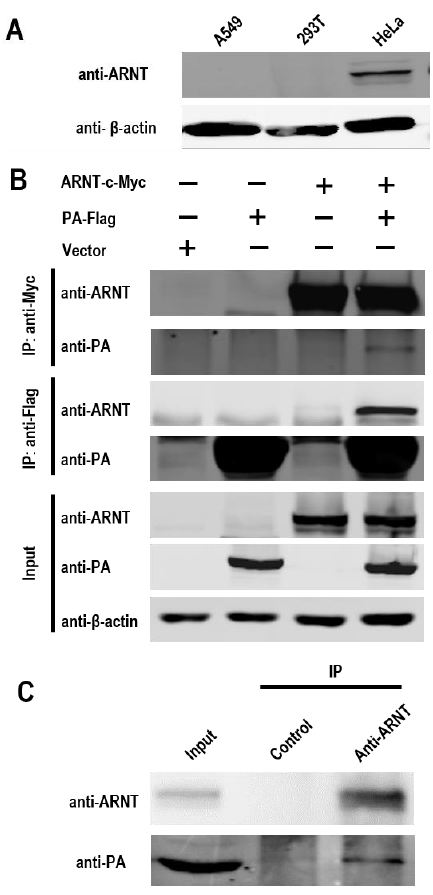
Figure 1. The interaction between ARNT and PA was analyzed by using co-immunoprecipitation assay. ( A ) The endogenous expression of ARNT in A549, 293T, and HeLa cells. ( B ) The interaction between PA and ARNT in 293T cells. 293T cells were co-transfected with the pCAGGS-PA-Flag and pCAGGS-ARNT-c-Myc plasmids. The cell extracts were subjected to co-immunoprecipitation assays by using either anti-Flag or anti-c-Myc antibodies to capture the immune complex. The bound proteins were then analyzed reciprocally by Western blotting with an anti-PA antibody to detect anti-c-Myc immunoprecipitates and an anti-ARNT antibody to detect anti-Flag immunoprecipitates. ( C ) The interaction between viral PA and endogenous ARNT in HeLa cells. HeLa cells were infected with GS/65 at an MOI of 2. At 24 h p.i., the cell extracts were immunoprecipitated with a rabbit anti-ARNT antibody or anti-control IgG antibody, followed by Western blotting with an anti-ARNT antibody and an anti-PA antibody.